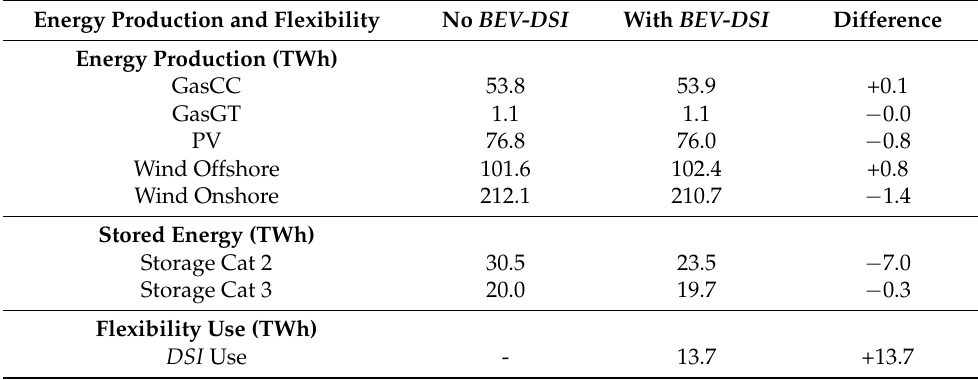
Table 5. Comparison of the resulting energy production and the use of flexibility options for the scenario with and without the possibility for BEV-DSI -usage.